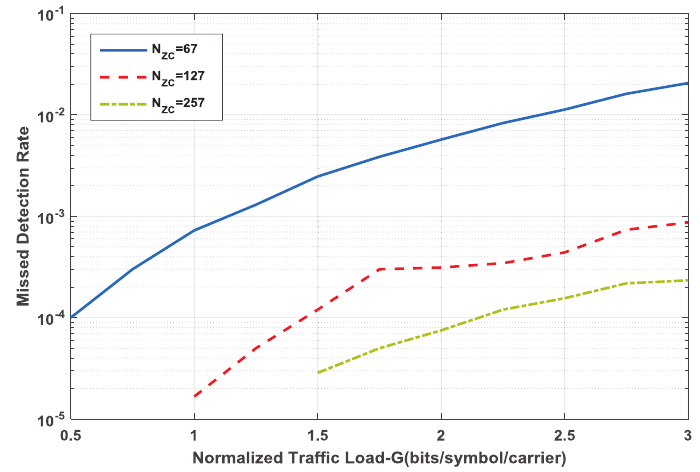
Figure 6. Pilot sequence detection performance for AF-SCMA (4, 6) with different ZC sequence length = 13 dB, without power unbalance and frequency of N ZC = 67,127 and 257, [ E b / N 0 ] D